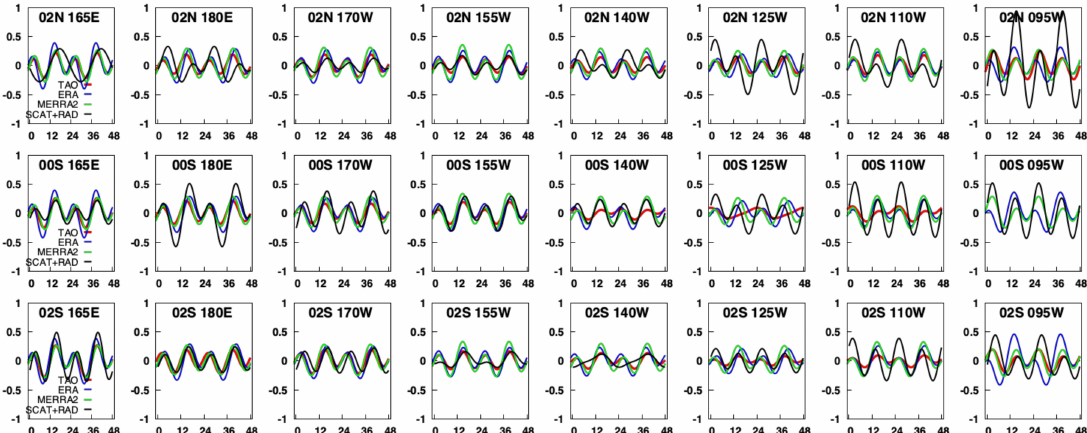
Figure 8. Map layout of the daily mode (sum of diurnal + semidiurnal components) zonal ( u ) wind component, at each of the 24 locations within the TAO-TRITON array (box area shown in Figure 5) using all data between 2007 and 2017. The x -axis extends from 0 to 48 h local time (two daily cycles) for enhanced visibility, and the y -axis extends between ± 1 m s − 1 . Positive (negative) values indicate westerly (easterly) winds relative to the daily mean. The estimates from the TAO moorings, ERA-I, MERRA2 and the scatterometer + radiometer (SCAT + RAD) analysis are represented by the red, blue, green and black line colors,